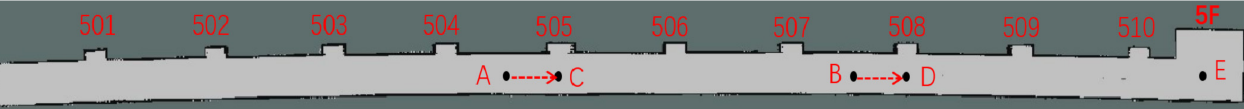
Figure 13. Schematic diagram of the robot kidnapping